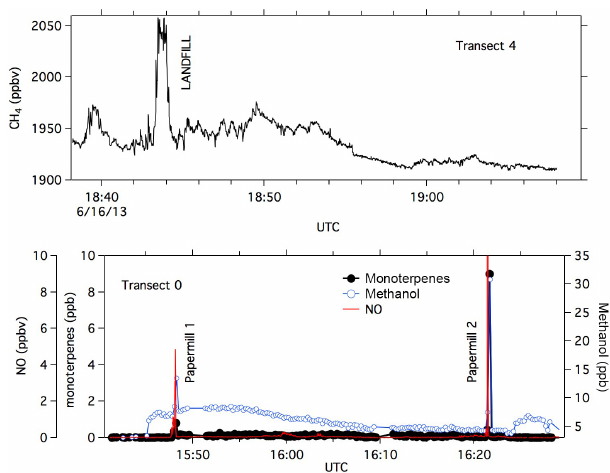
Figure 10. Time series of two transects during the 16 June 2013 flight downwind of a landfill and two paper